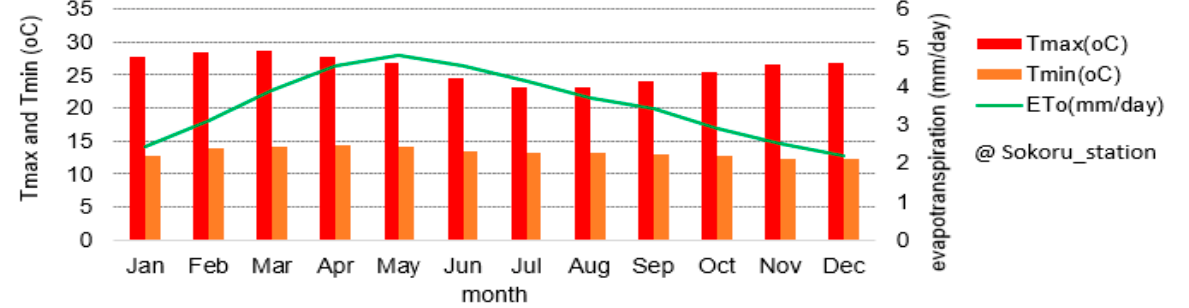
Figure 11. Average maximum and minimum temperature and evapotranspiration at Sokoru weather station (1987–2014).